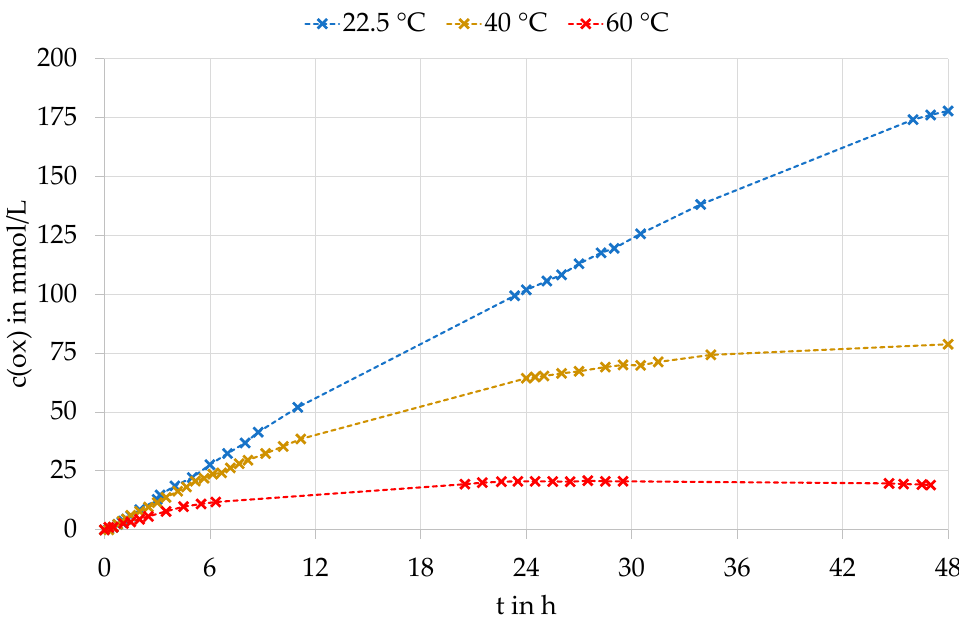
Figure 8. Progression of the concentration of anodically formed oxidants (c(ox)) (one-electron- transition assumed), depending on the temperature during electrowinning with a diamond anode at 40 °C.